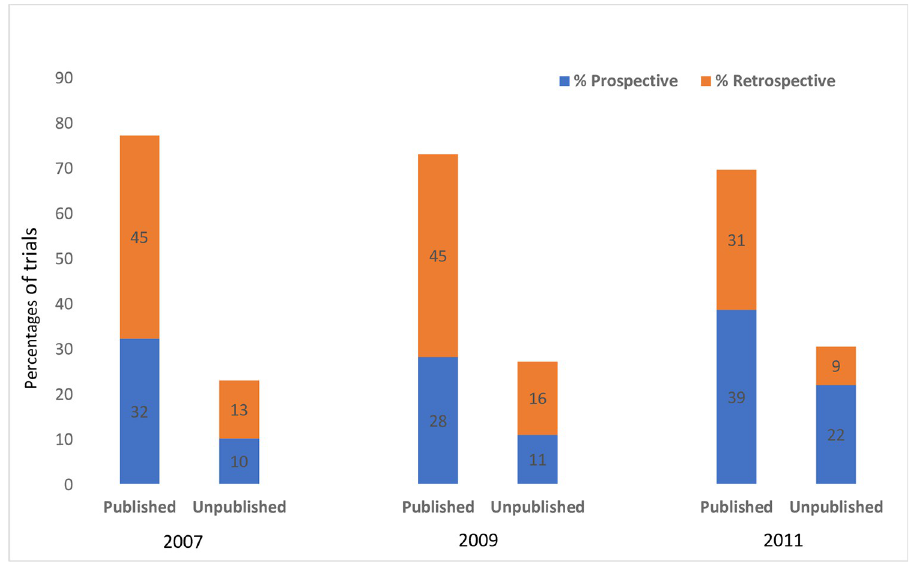
Fig 4. Percentage of published and unpublished trials prospectively and retrospectively registered over time (n = 1,970).